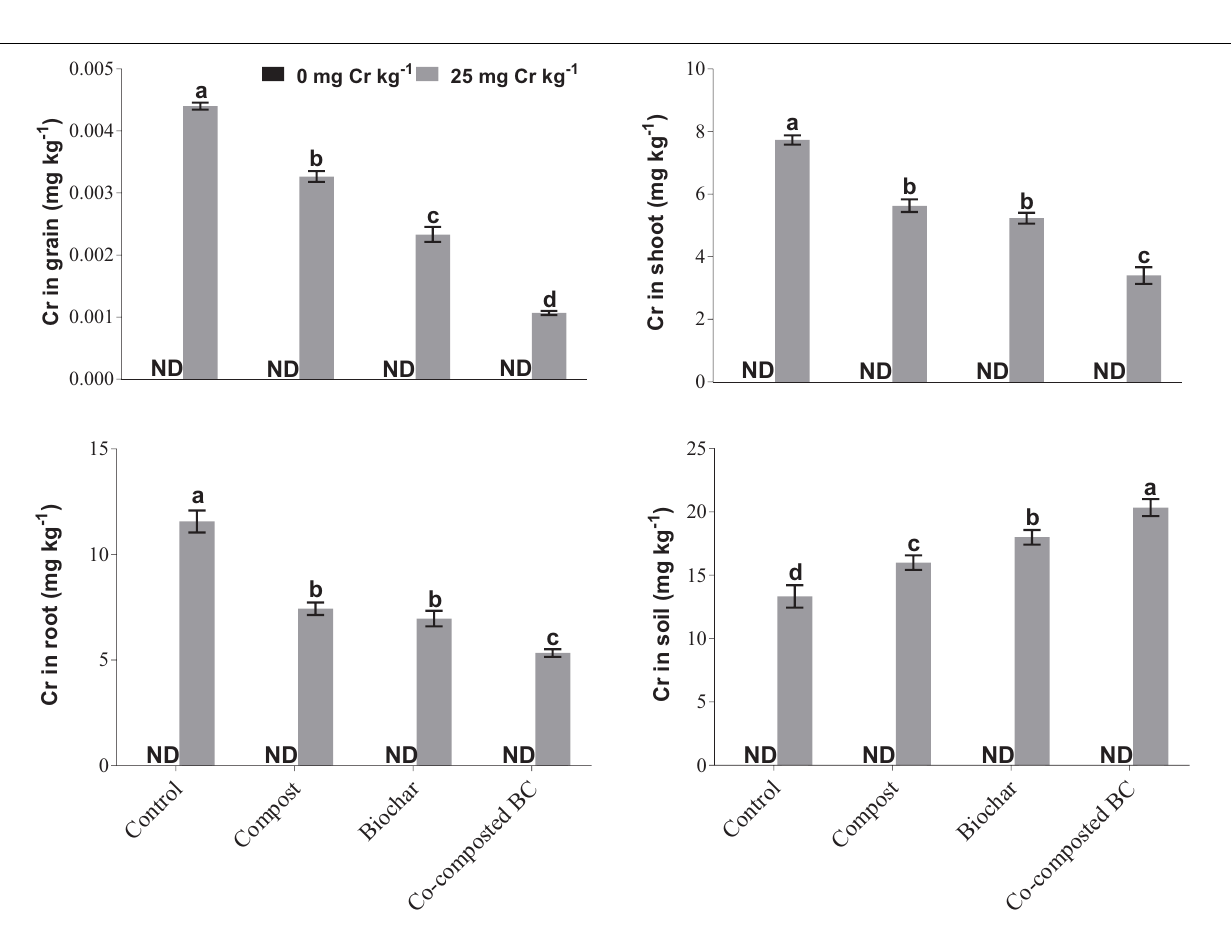
Frontiers in Plant Science |